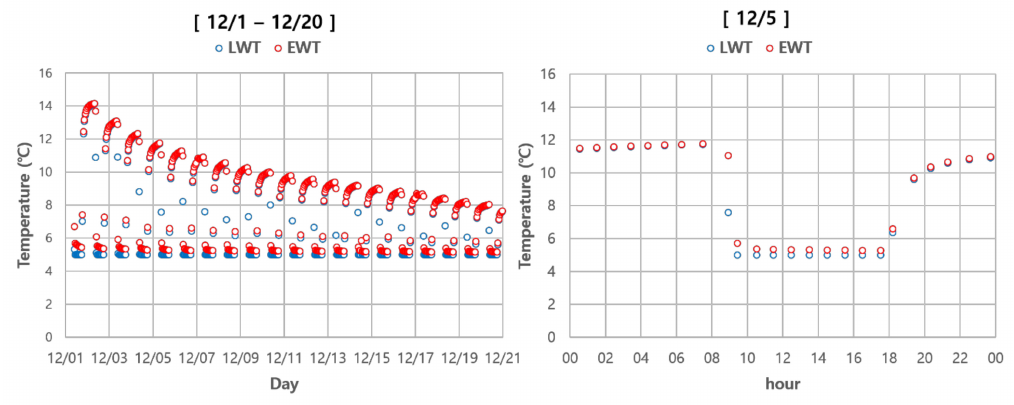
Figure 5. Leaving and entering water temperature.